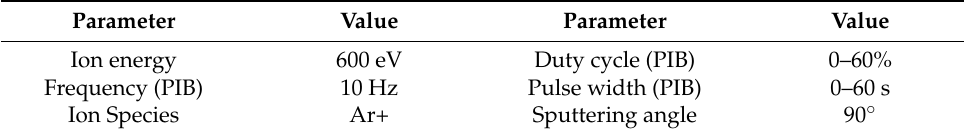
Table 1. The PIB and IBF processing parameters.